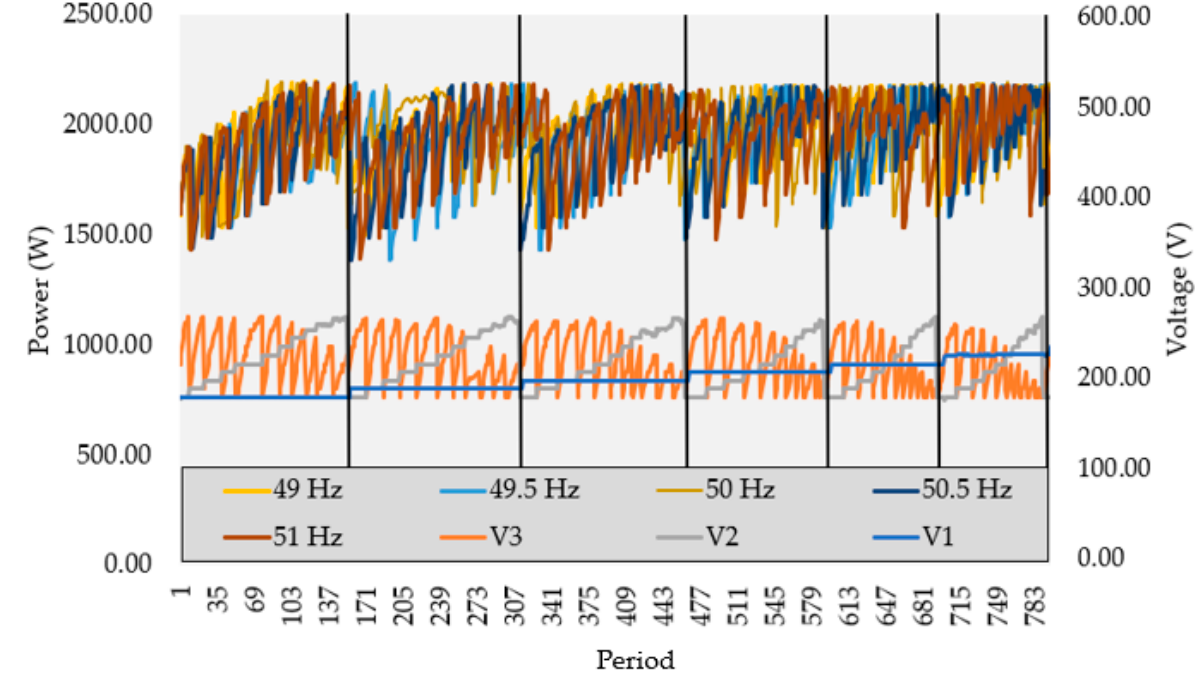
Figure 12. Experimental results from the OP5600 for different frequency and voltage levels.